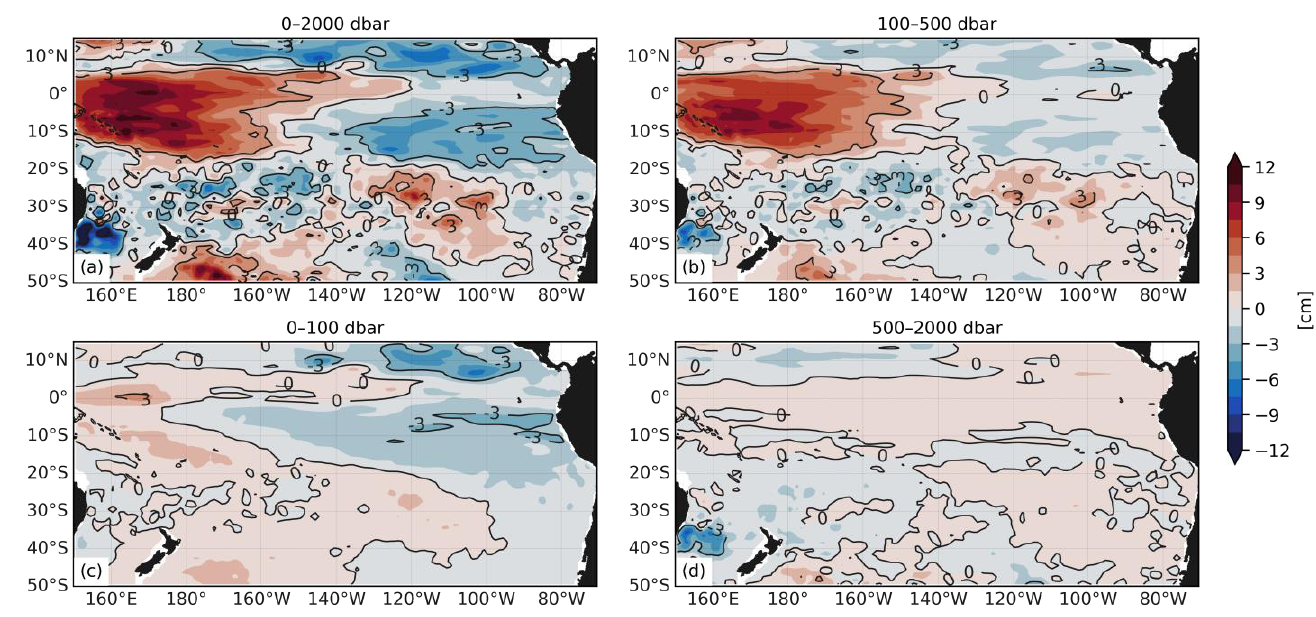
Figure 5. Differences in the Roemmich-Gilson Argo-based thermosteric sea level (TSL) for 2018 minus 2016 over ( a ) 0 – 2000 dbar, ( b ) 100 – 500 dbar, ( c ) 0 – 100 dbar and ( d ) 500 – 2000 dbar. Contour lines (see inline numbers for TSL intervals) are also shown.